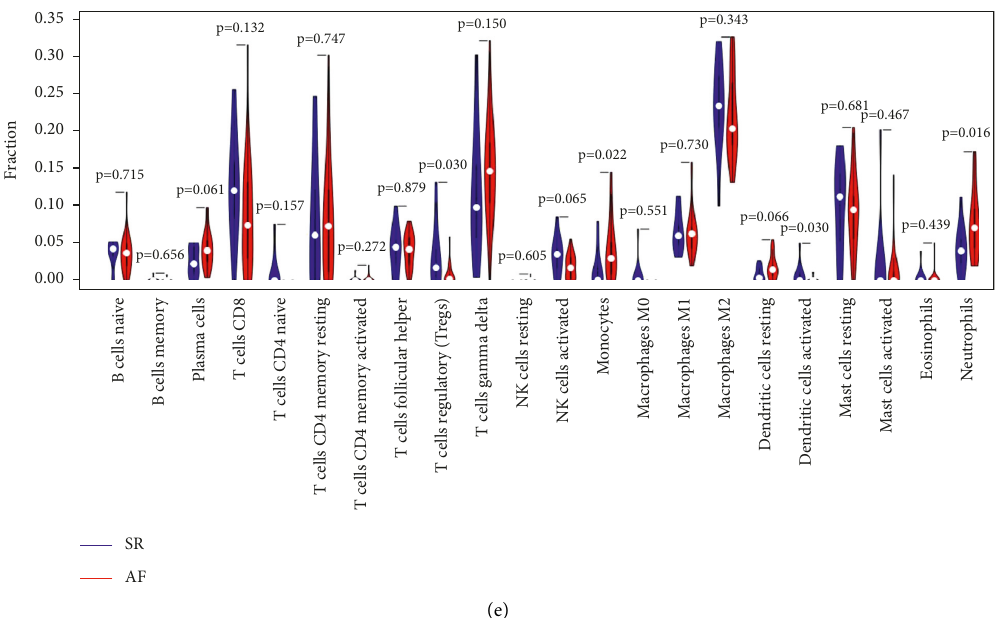
Figure 8: Analyses of immune infiltration in atrial fibrillation. The relative percentage (a) and heatmap (b) of 22 types of immune cells. (c) Principal component analysis of immune cells in atrial fibrillation and normal controls. (d) The correlation of the infiltration of innate immune cells. (e) Comparison of 22 immune cell subtypes between patients in atrial fibrillation and